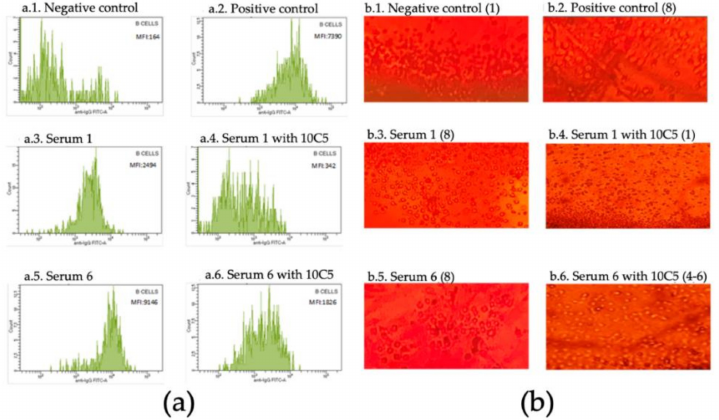
Figure 1. ( a ) Histogram of the anti-IgG in the flow cytometry of B cells; MFI (median fluorescence intensity) values are shown; ( b ) complement-dependent cytotoxicity of B cells; reading values are indicated in